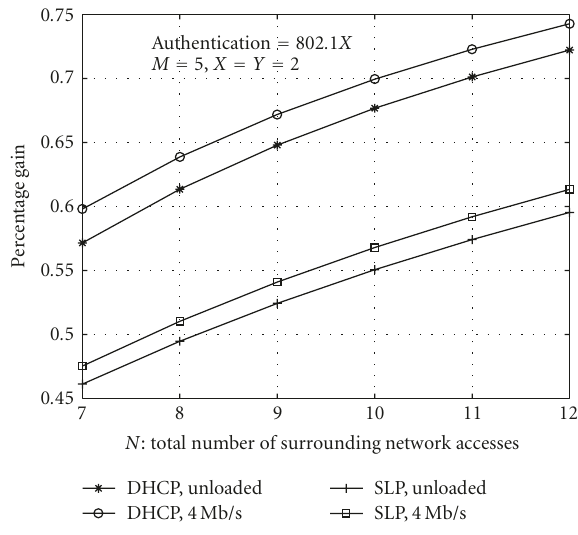
Figure 16: Percentage gain versus N : 802.1X-based authentication.